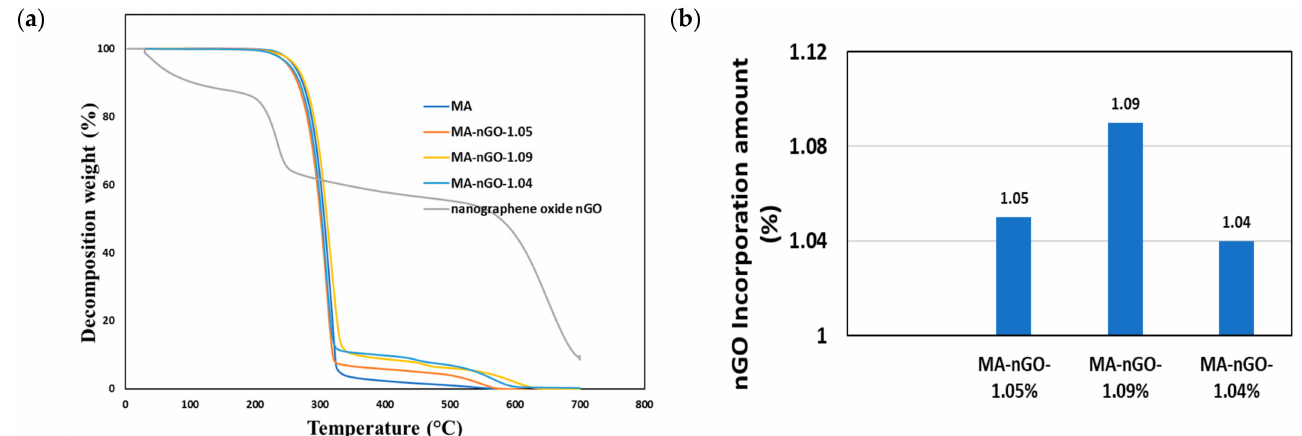
Figure 8. ( a ) Thermogravimetric analysis (TGA) of drug composites and ( b ) computed nGO